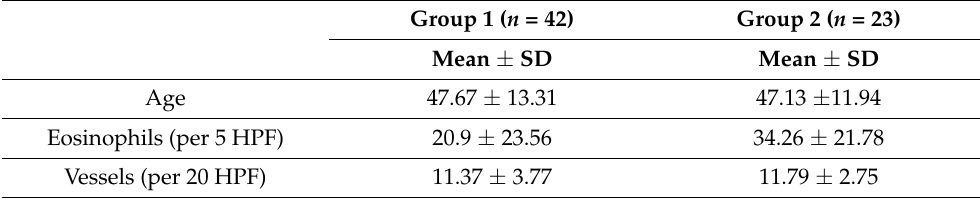
Table 1. Patient characteristics.